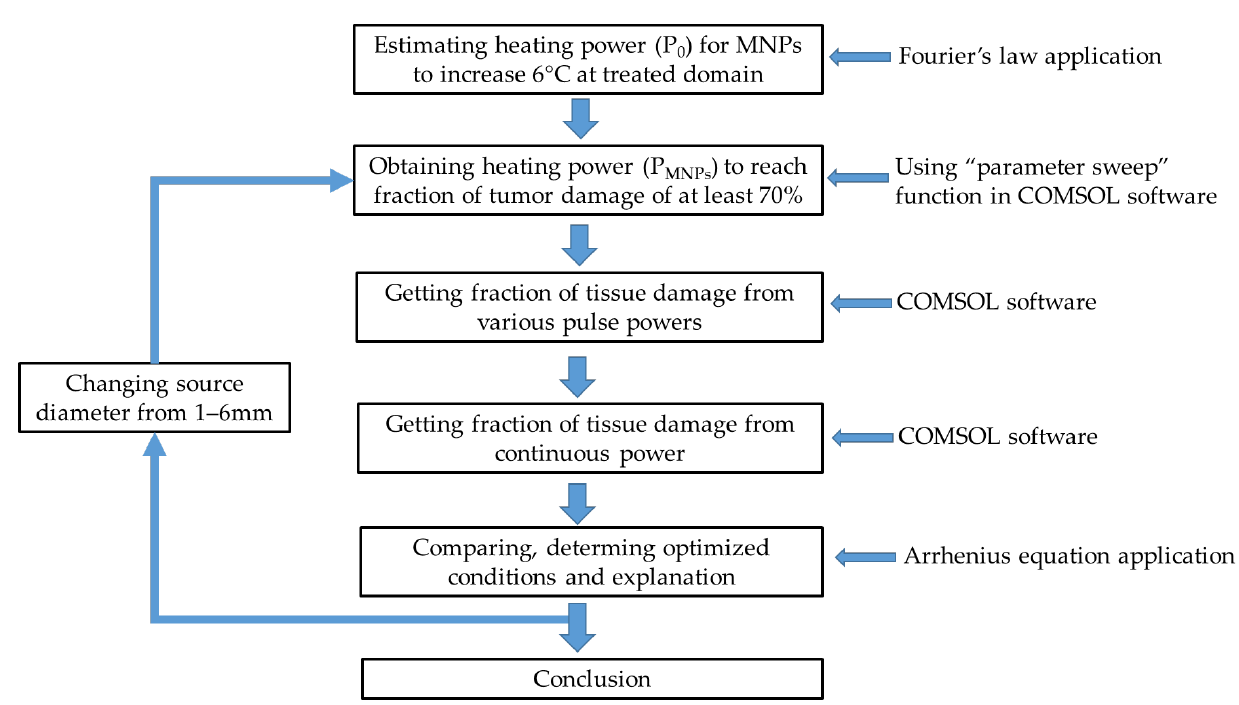
Figure 7. Flowchart of the methods and processes used in this simulation.